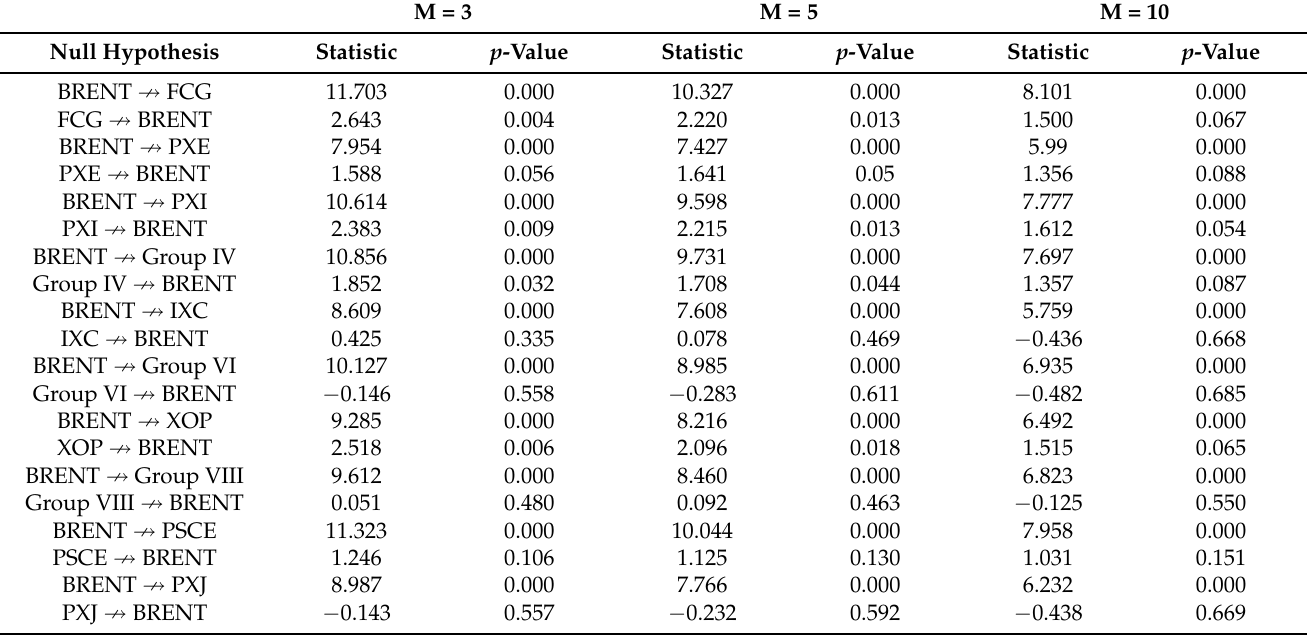
Table 1. Hong test